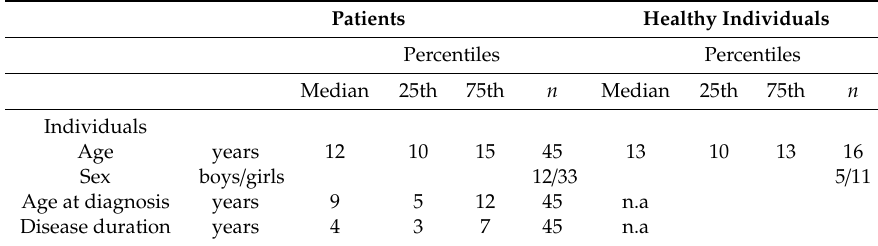
Table 1. Demographic data 45 patients with juvenile idiopathic arthritis and 16 age- and sex-matched healthy